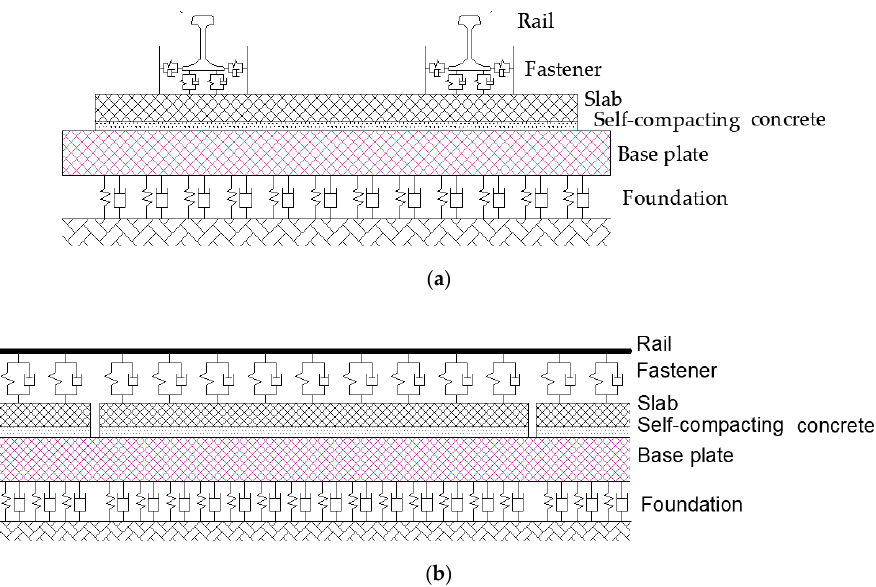
Figure 7. The CRTSIII SBT structure system. ( a ) Lateral structure; ( b ) longitudinal structure. Table 3. Finite element for each structure.